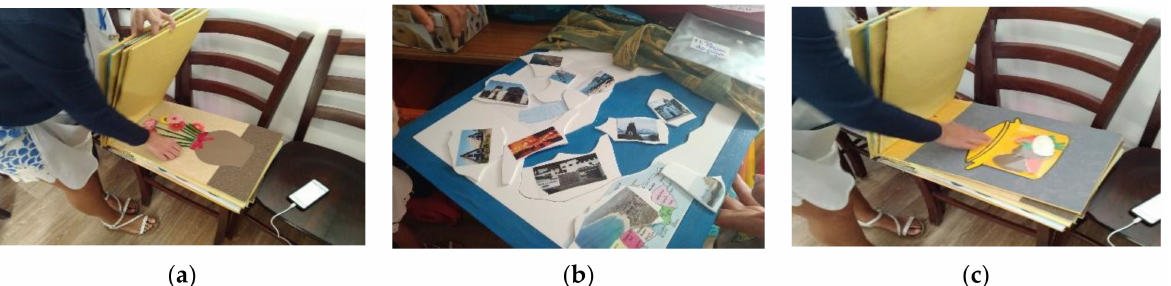
Figure 2. Themes and activities used by formal caregivers for cognitive stimulation of IwD. ( a ) multi-sensorial stimulation activity; ( b ) reminiscence-based stimulation activity; and ( c ) activities of daily living-based stimulation activity.